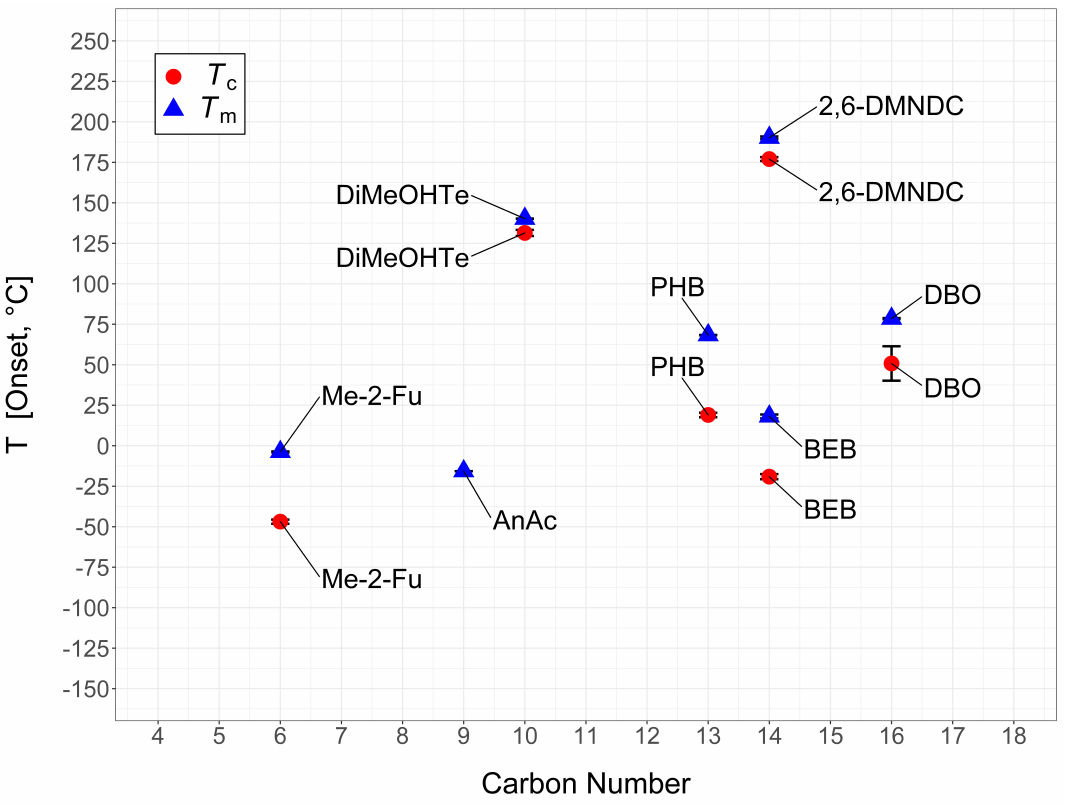
Figure 2. Scatter plot of the average onset melting points ( T m , red triangle) and crystallization points ( T c , blue circle) plotted against the carbon numbers (Carbon Number). The aromatic esters for which the phase change temperatures could not be determined do not appear in the plot. The error bars represent the standard deviation between the melting point of three repeated measurements for each compound, with the exception of AnAc and of BEB’s T m . In general a wide range of temperature is observed, with a maximum T m of 190 ◦ C for 2,6-DMNDC and a minimum T m of − 16 ◦ C for AnAc. A high degree of supercooling is visible for all samples except DiMeOHTe and